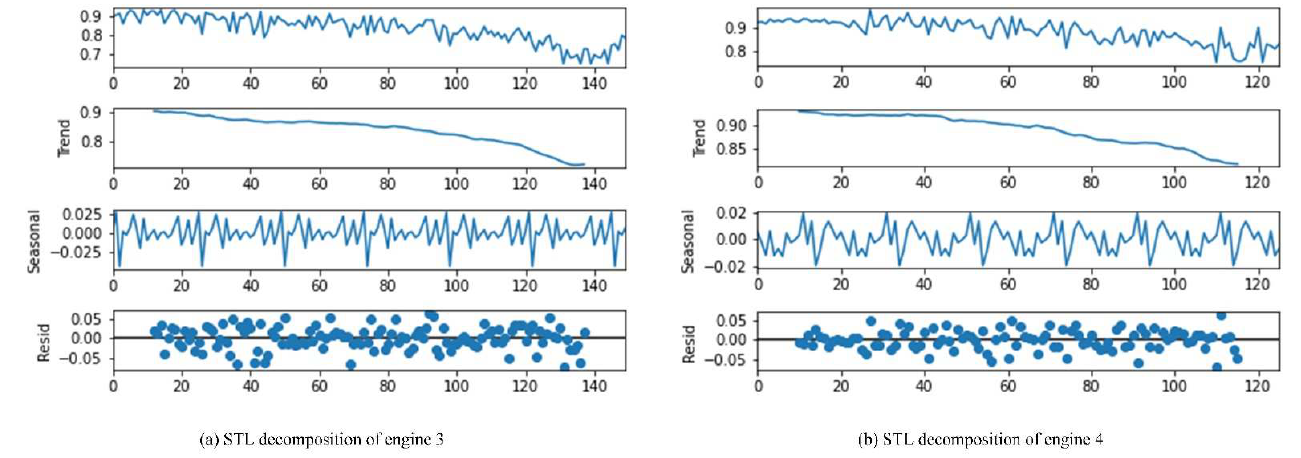
Figure 12. Degradation trajectory decomposition.